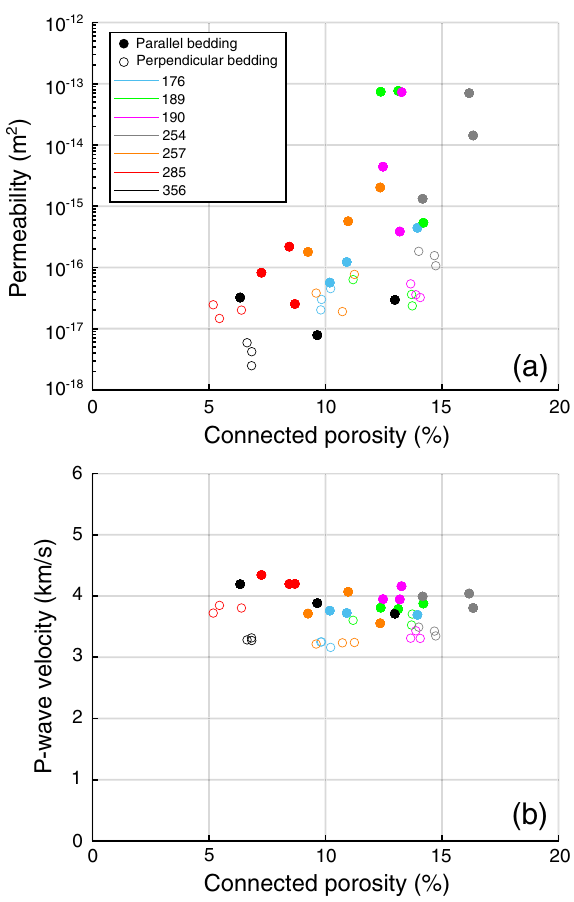
Fig. 9 a Permeability and b P-wave velocity as a function of connected porosity for the 42 samples of Buntsandstein sandstone prepared for this study. Samples were prepared either parallel (filled circles) or perpendicular (unfilled circles) to bedding. The number refers to the box